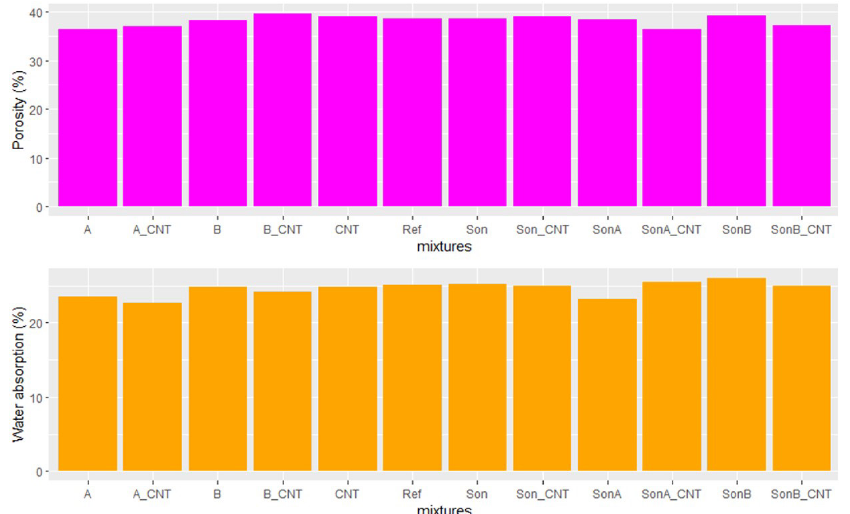
Figure 13. Porosity and water absorption of the hardened Portland cement